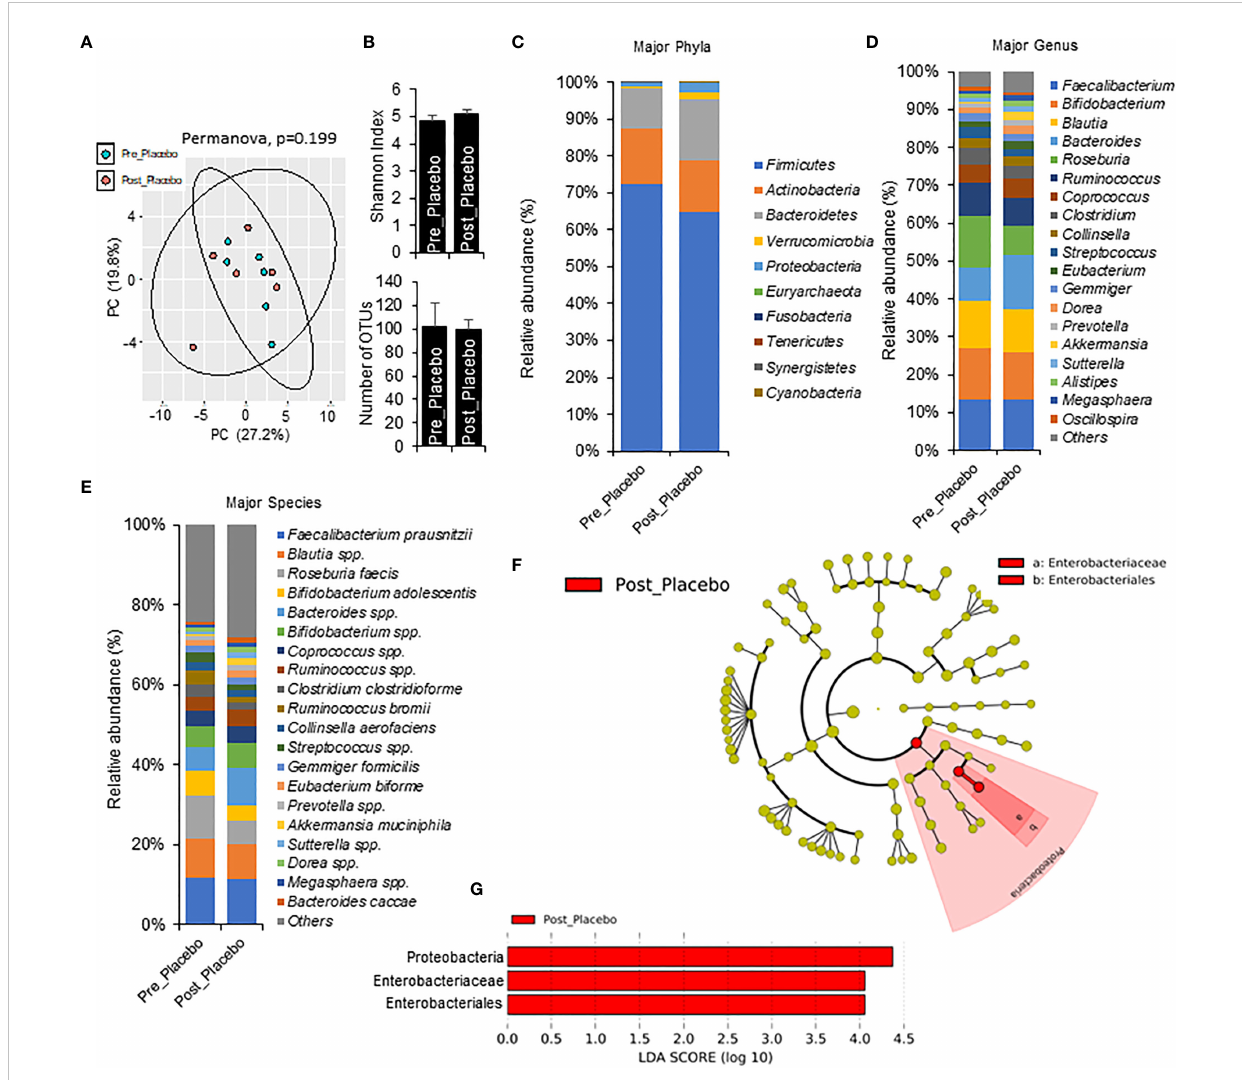
FIGURE 3 Microbiome signatures in pre metformin/place compared to Phase 1 Metformin/Placebo. (A, B) Principal component analysis of beta-diversity and alpha-diversity measure, Shannon Index, and number of OTUs did not differ between Pre_Placebo (pre metformin/placebo) to Post_Placebo (Phase 1 metformin/placebo). (C – E) There were modest changes in abundance of major phyla, genus, and species differs between Pre_Placebo and Post_Placebo. (F, G) LEfSe (Linear discriminant analysis Effect Size) analysis showed unique biomarkers in Pre_Placebo vs Post_Placebo. Data are mean and standard error of mean. Microbiome beta-diversity was assessed using the Bray-Curtis dissimilarity index and visualized with principal component analysis. The alpha-diversity indices and bacterial proportions were compared using the Kruskal-Wallis test followed by the Mann- Whitney multiple pairwise comparison